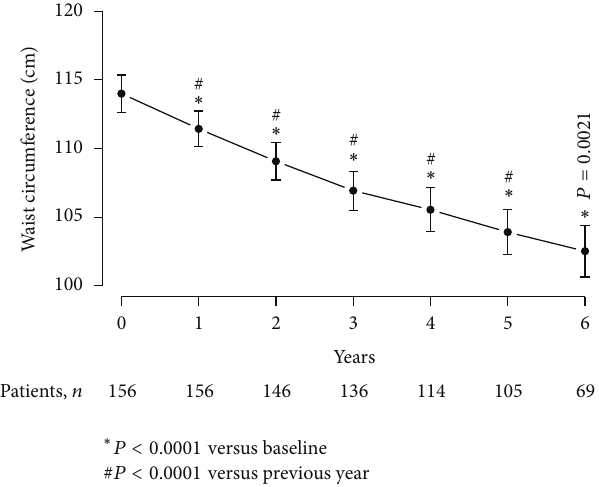
Figure 1: Waist circumference (cm) in 156 obese hypogonadal men with type 2 diabetes mellitus treated with testosterone undecanoate injections for up to 6 years.